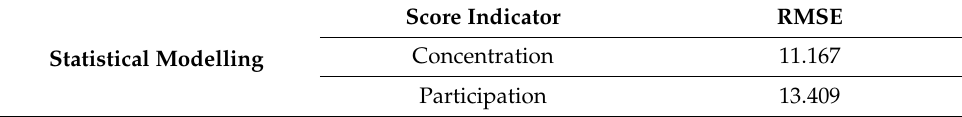
Table 7. Performance analysis for score indicators evaluated by the statistical modeling module. Score Indicator RMSE Concentration 11.167 Statistical Modelling 13.409